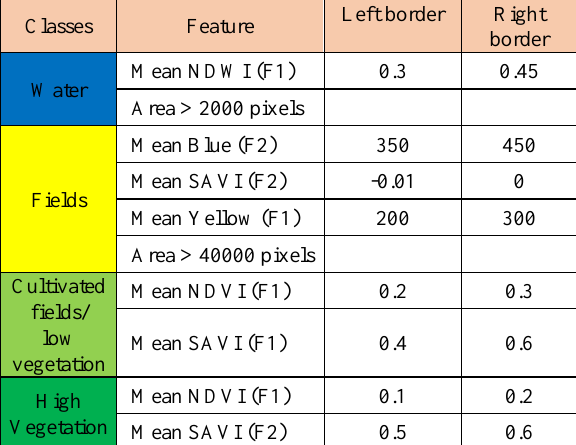
Table 3 . Feature used to classify the “natural elements” in the